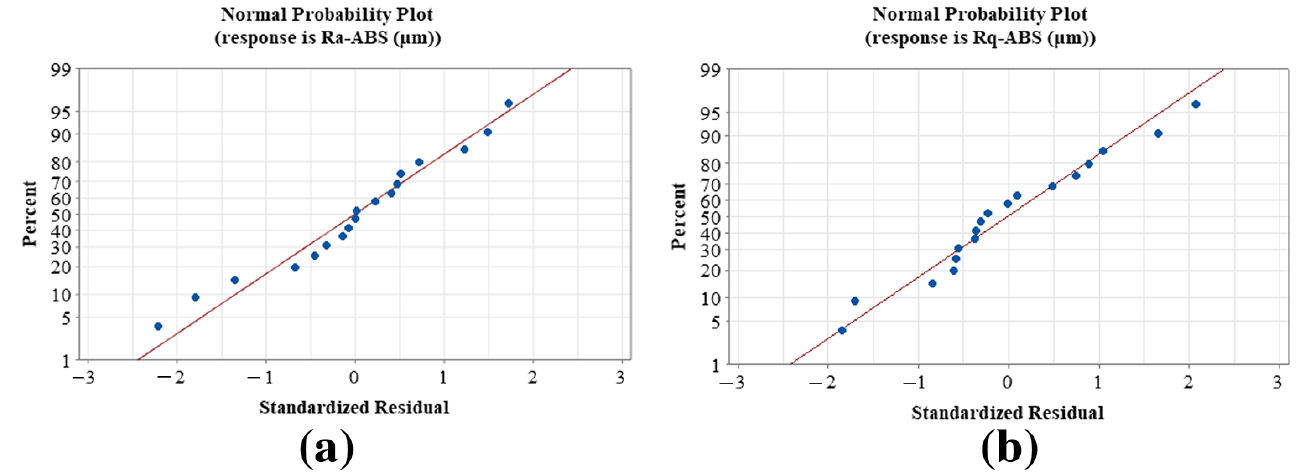
Figure 15. Normal probability graph for the residuals of polymers: ( a ) Ra-ABS and ( b ) Rq-ABS.